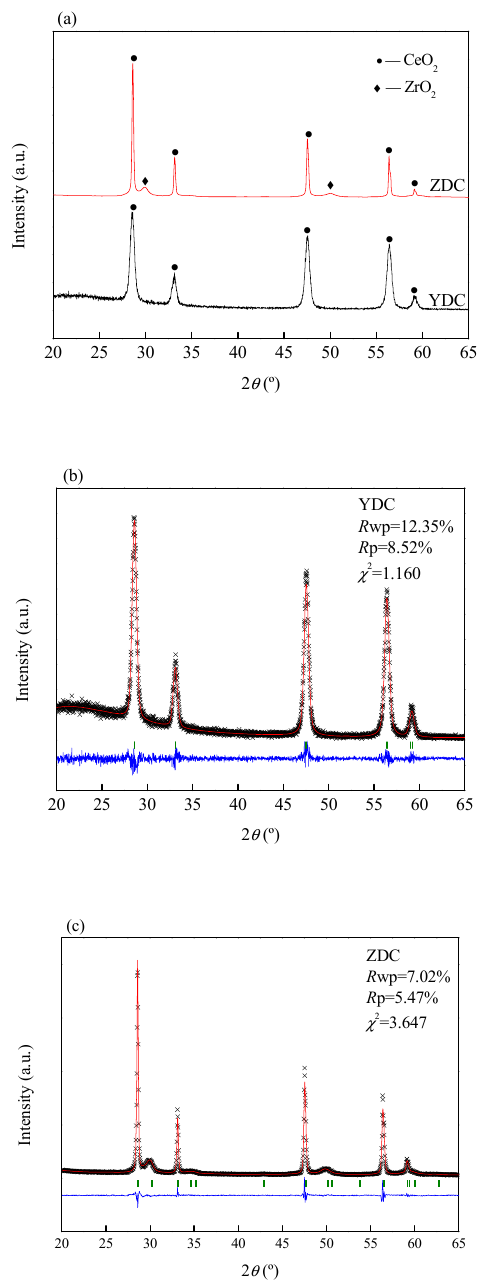
Figure 3. ( a ) Crystal structure of the YDC and ZDC, ( b , c ) unit cell constants of YDC and ZDC.